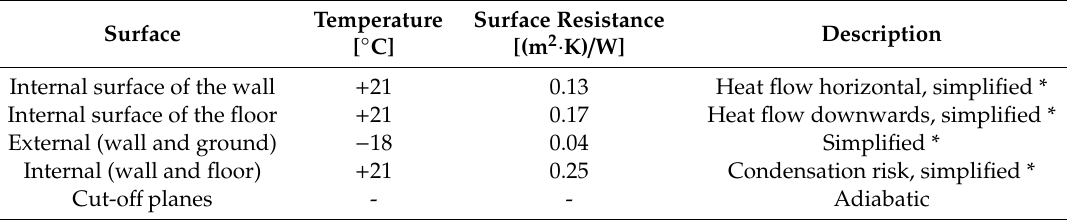
Table 3. Boundary conditions adopted in